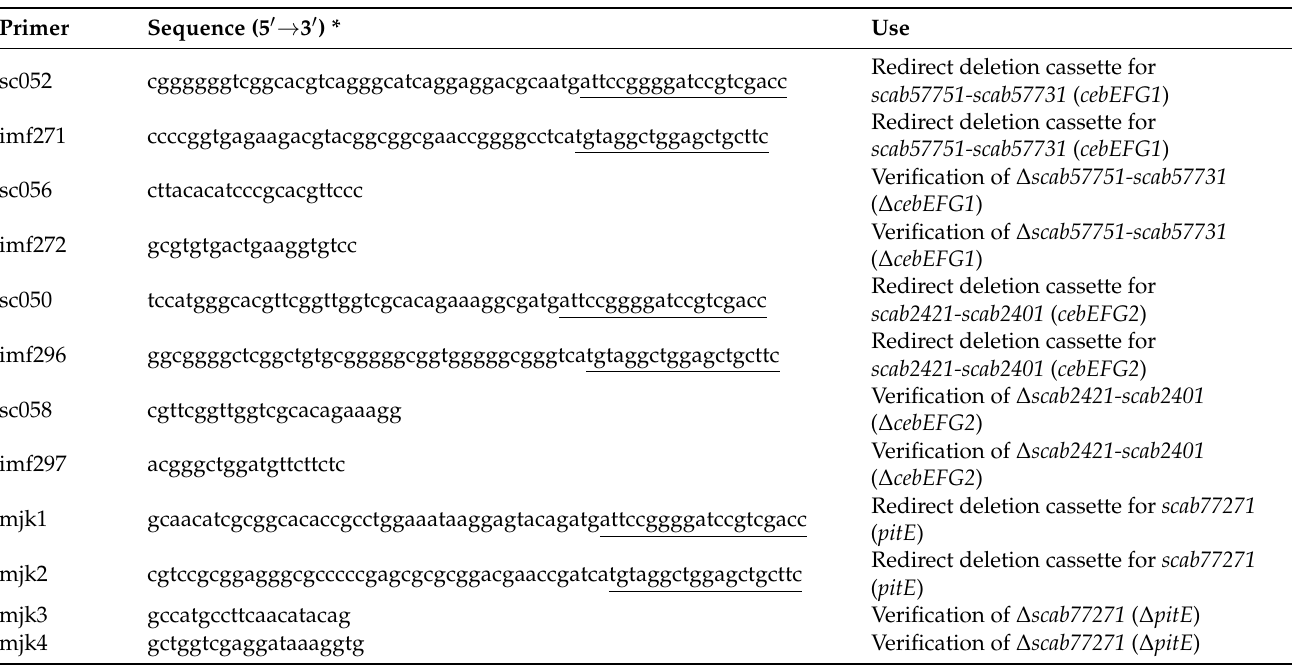
Table A3. Primers used in this